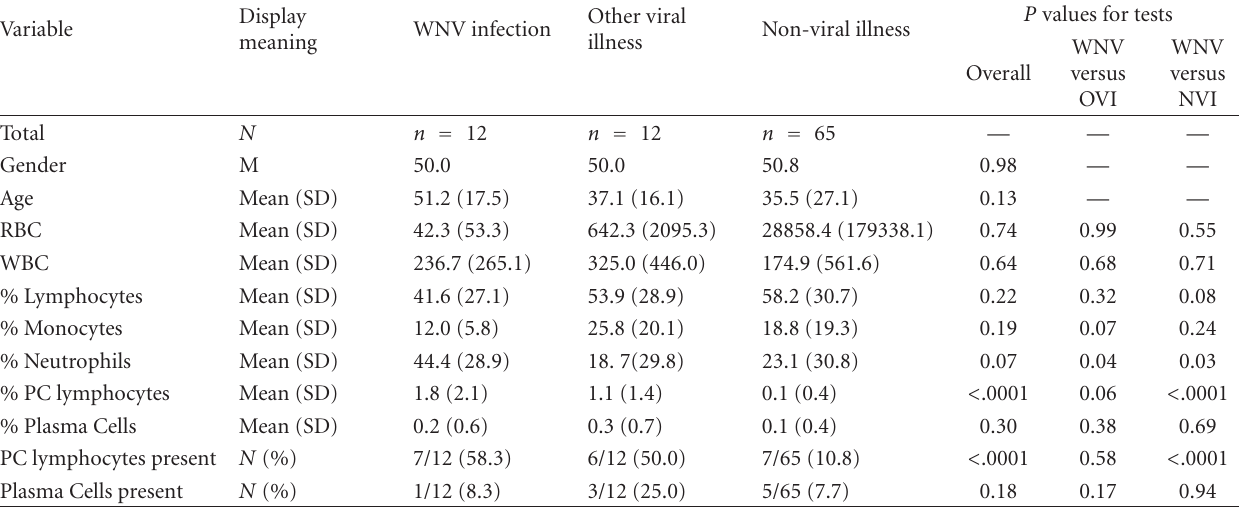
Table 1: CSF cell count findings in WNV-infected patients versus patients with other viral illness (OVI) or non-viral illness (NVI).